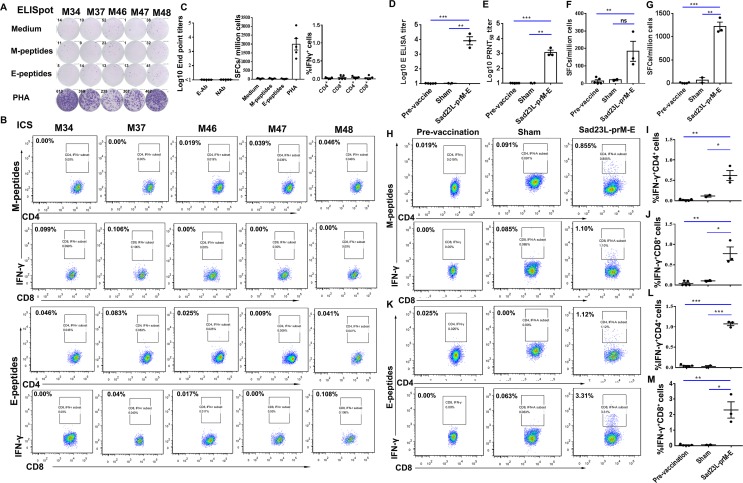
Humoral and cellular immune response of common marmosets to Sad23L-prM-E vaccine.Baseline values of antibody and T-cell responses for pre-vaccination were tested individually in the sera and PBMCs of five marmosets (week 0), and a mean value was calculated as a background for each reaction in marmosets. (A) Testing of the background of IFN-γ secreting spot forming cells (SFCs) per million PBMCs to M or E peptides by ELISpot. (B) Testing of the background of intracellular IFN-γ+ CD3+CD4+ or IFN-γ+ CD3+CD8+ cells to M or E peptides by ICS assay. (C) The baseline values of E-binding and neutralizing antibodies and T cell responses in pre-vaccination marmosets. Three marmosets were immunized with a single dose of 3×108 PFU Sad23L-prM-E vaccine and two marmosets were inoculated with PBS as sham vaccine. From these vaccinated or sham marmosets, sera and PBMCs were isolated to test specific antibody and T-cell responses at 4 weeks post-immunization, and to compare with pre-vaccination values. (D) E-Ab was detected by ELISA. (E) NAb was detected with PRNT50. (F and G) The number of IFN-γ SFCs per million PBMCs to M or E peptides was measured by ELISpot, respectively. (H-J) The percent of intracellular IFN-γ+ CD3+CD4+ or IFN-γ+ CD3+CD8+ cells to M peptides was detected by ICS assay. (K-M) The percentage of intracellular IFN-γ+CD3+CD4+ or IFN-γ+CD3+CD8+ cells to E peptides was detected by ICS assay, respectively. Data are shown as a mean ± SEM (standard errors of means). P values are analyzed with one-tailed t test. Statistically significant differences are shown with asterisks (*, P<0.05; **, P< 0.01 and ***, P< 0.001). ns, no significant difference.